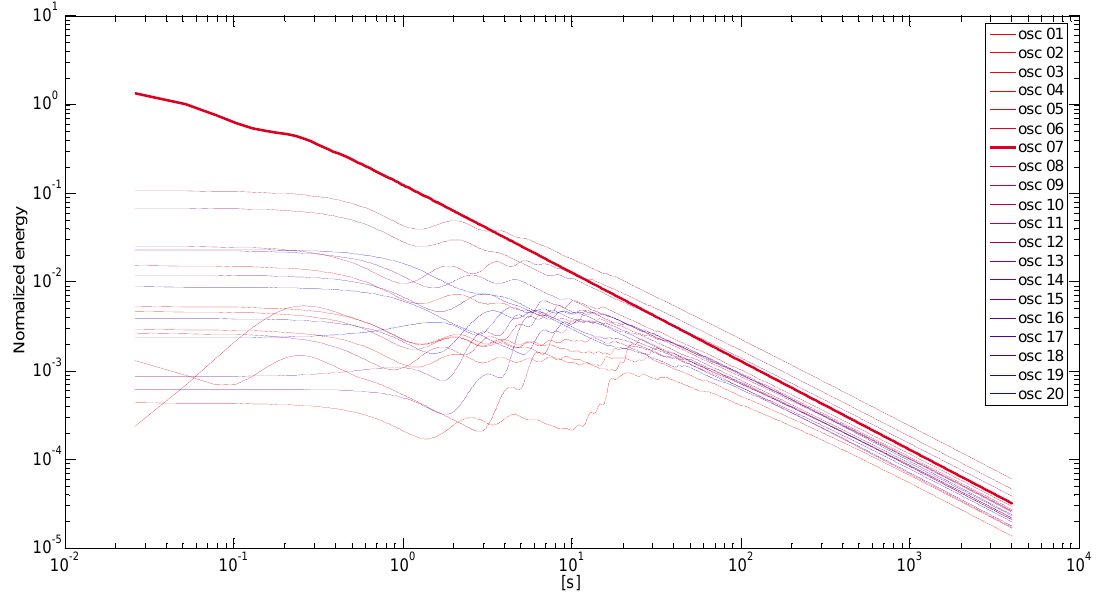
Fig. 15. Chain with mass focus with non-proportional damping, time energy averages versus time, x, y axes in log scale.